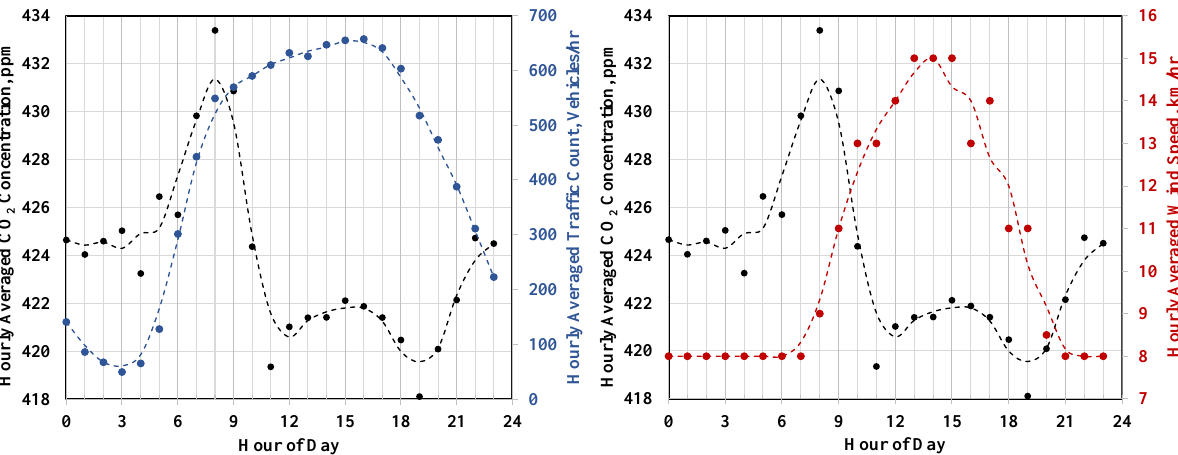
Figure 10. Comparison of average hourly CO 2 levels with total observed hourly traffic density (left) and averaged hourly windspeed (right) for weekday periods for device O1 during the period of August 12–September 25, 2019. Highly similar results were found at each of the four monitoring